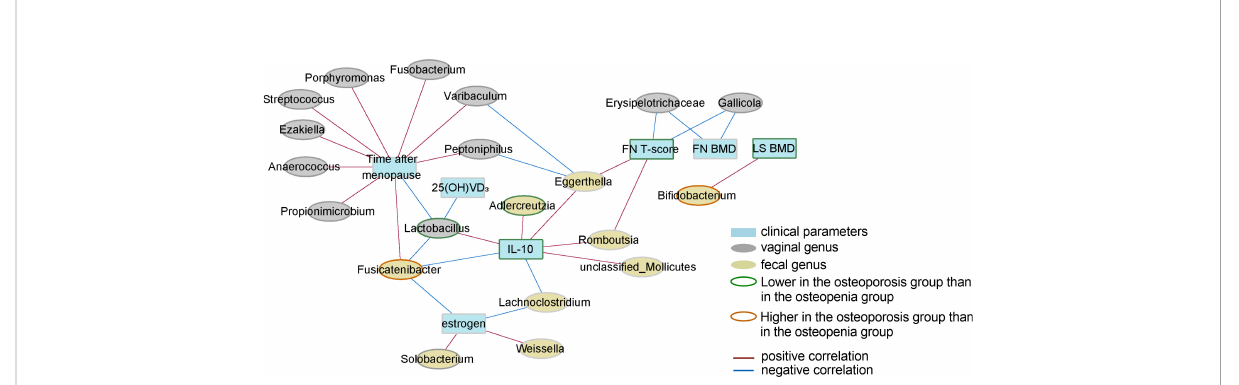
FIGURE 6 Correlation network of key genera in GM and VM, the levels of in fl ammatory factors, and clinical phenotypes. Only correlations with FDR values < 0.05 are shown. The width of a line represents the absolute value of the Spearman correlation coef fi cient. The color of a line represents correlation type; blue represents a negative correlation, whereas red represents a positive correlation. The node border color represents the result of the comparison of genera/parameters between the osteoporosis and osteopenia